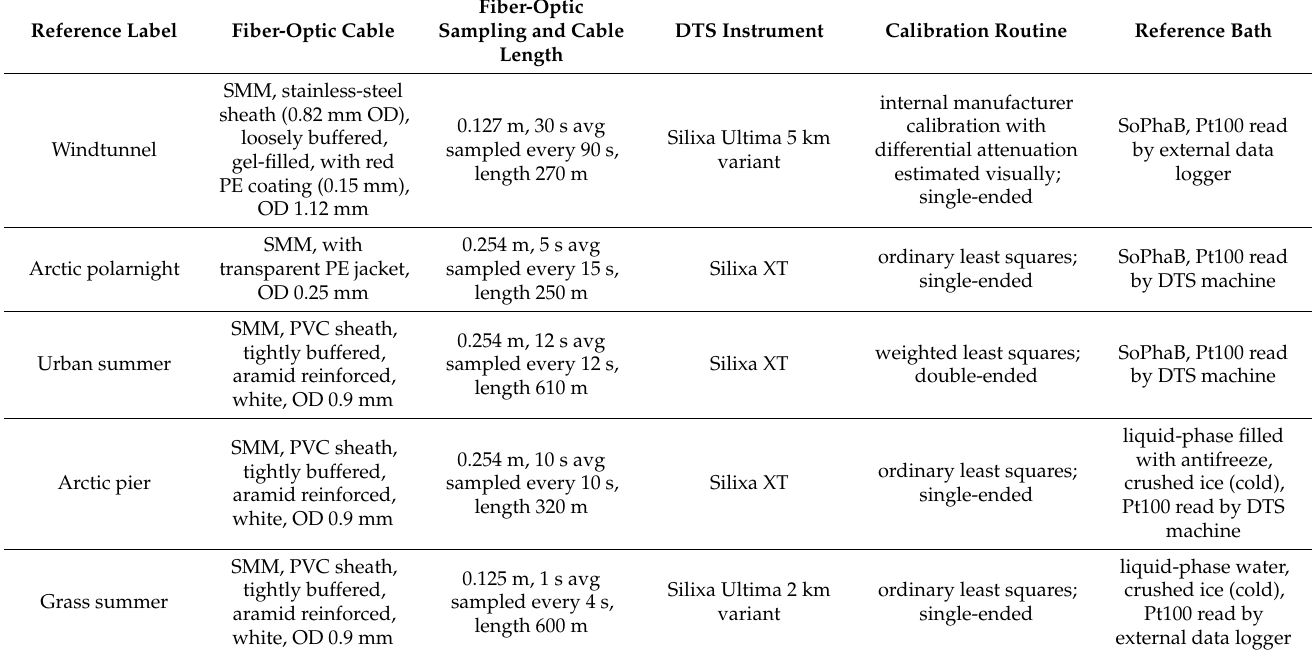
Table 1. Short description of fiber-optic distributed sensing experiments and calibration parameters used for evaluating SoPhaB performance. SMM refers to single-core multimode glass fiber of 50 µ m outer diameter (OD), avg for averaging, PVC is polyvinyl chloride, PE polyethylen, Pt100 the platinum wire reference thermometers, DTS is Distributed Temperature Sensing. FODS observations were selected for a 300 min period each. Names of calibration routines refer to methods described in des Tombe et al. [16] except for Windtunnel. Models of DTS instruments refer to those of Silixa Ltd., Hertfordshire,